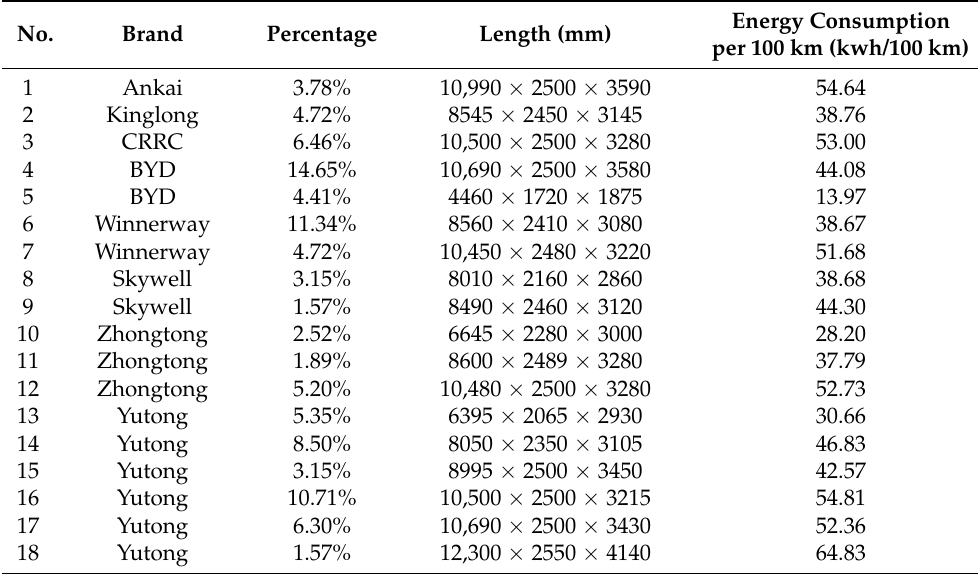
Table 7. Relevant parameters of electric buses of different